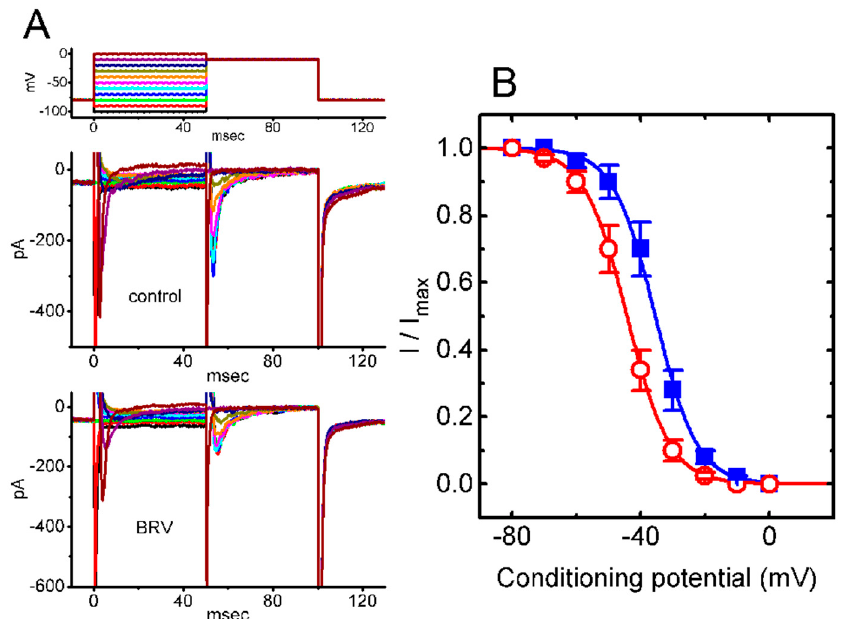
Figure 5. BRV-induced modifications to the steady-state inactivation curve of peak I Na recorded from GH 3 cells. In this set of experiments, the cells were immersed in a Ca 2+ -free Tyrode’s solution containing 10 mM tetraethylammonium chloride, where the pipette was filled with Cs + -containing solution. ( A ) Representative I Na traces obtained without (upper view) and with addition of 10 µM BRV (lower view). The uppermost part indicates the voltage profile used, where the different colors correspond to the different command voltages; ( B ) Steady-state inactivation curve of peak I Na in the absence ( ■ ) and presence ( ○ ) of 10 µM BRV (mean ± SEM; n = 7). It should be noted that a significant leftward (i.e., hyperpolarizing) shift along the voltage axis in the inactivation curve of the current was detected in the presence of 10 µM BRV), while the slope (i.e., gating charge [ q ]) of the curve remained unaffected.